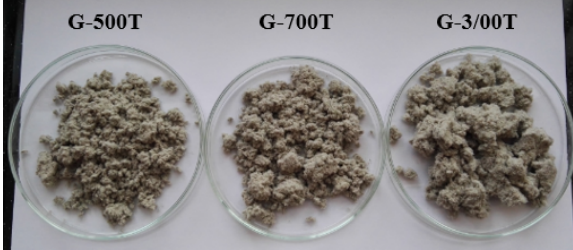
Figure 1: Recycled cellulosic waste paper fibres (grey colour)